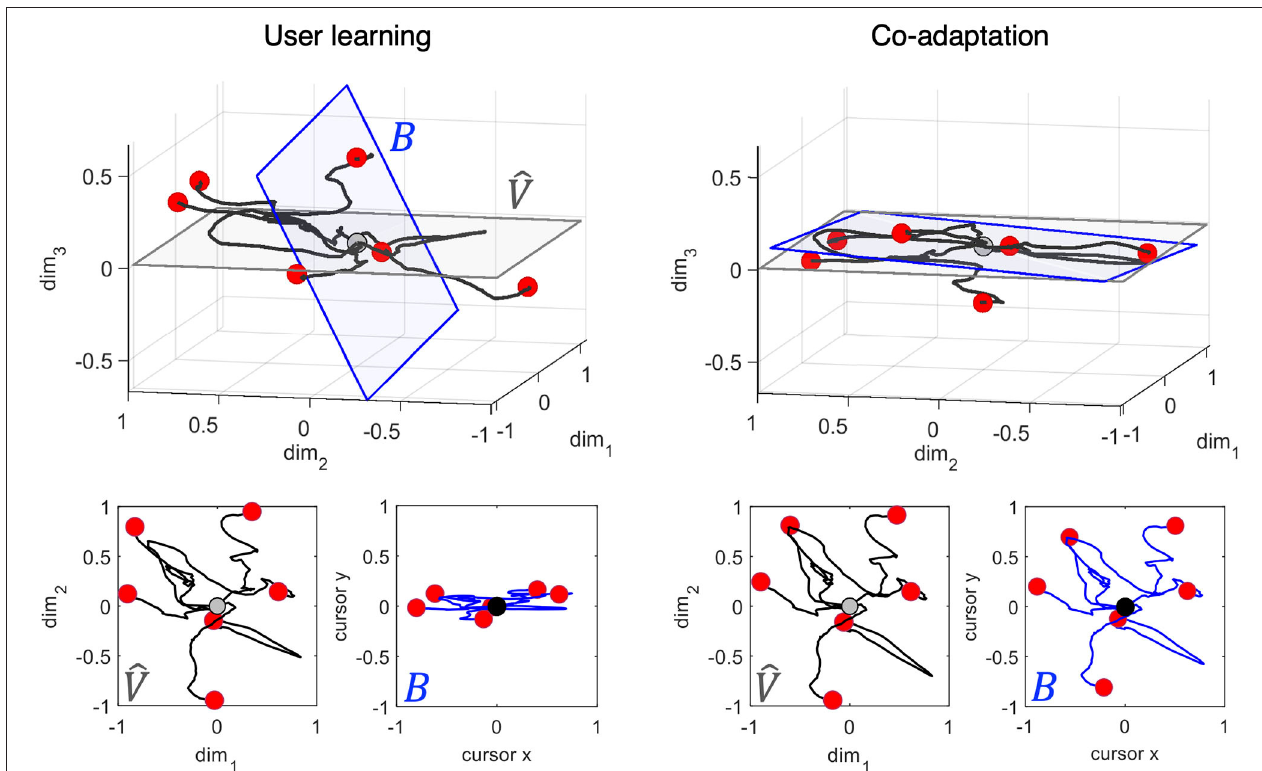
FIGURE 6 | Control efficiency after user learning vs. co-adaptation. Projection of six simulated smooth trajectories in the 8D space of the sensors into (top panels) the first three eigenvectors of the user model movement distribution, (bottom panels) the first two eigenvectors of the user model movement distribution and the corresponding 2D cursor movement at iteration 1000. The user model was trained with η = 0.0013 in both conditions, while the interface had γ = 0 in the user learning condition, and γ = 0.0013 during co-adaptation. The trajectories in body space are depicted in black, while the corresponding cursor trajectories are depicted in blue. All trajectories start from the origin. Red circles denote the end of a trajectory (the equivalent of a target point). The blue hyperplane B represents the subspace of the cursor coordinates defined by the interface map, the gray hyperplane represents the subspace spanned by the first two components of body movement variance ( ˆ V ). The subspace angle between B and ˆ V was 69.12 deg in the User Learning condition and 21.79 deg in the Co-learning condition at iteration 1000.